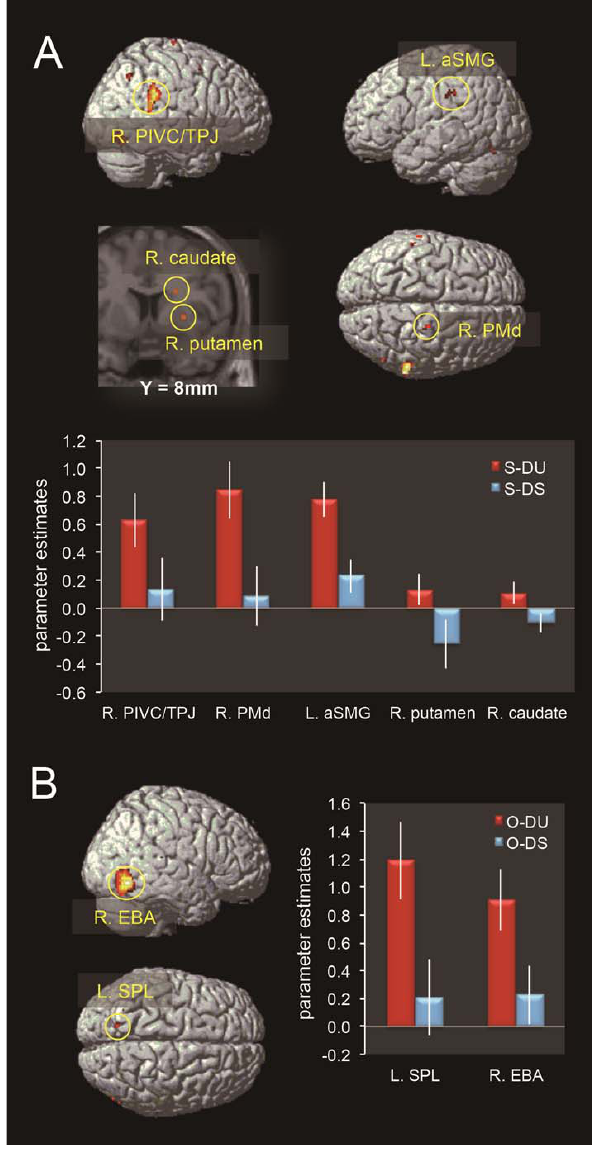
Fig. 3. Brain activity in the DU vs. DS contrast for self and others. A: Brain regions significantly activated for the Self DU vs. Self DS contrast, and the eigenvariate values (parameter estimates, mean ¡ standard error) in the spherical region of interest (ROI; radius, 5 mm) whose center was the peak voxel at each cluster showing significant activity in the above contrast, in each of the Self DU (S-DU) and Self DS (S-DS) comparisons. B: Brain regions significantly activated for the Others DU vs. Others DS contrast, and the eigenvariate values in the spherical ROI (radius, 5 mm) whose center was the peak voxel at each cluster showing significant activity in the above contrast, in each of the Others DU (O-DU) and Others DS (O-DS) comparisons. R: right, L: left, PMd: dorsal premotor area, PIVC: parieto-insular vestibular cortex, TPJ: temporo-parietal junction, IPL: inferior parietal lobe, aSMG: anterior supramarginal gyrus, EBA: extrastriate body area, SPL: superior parietal lobe.